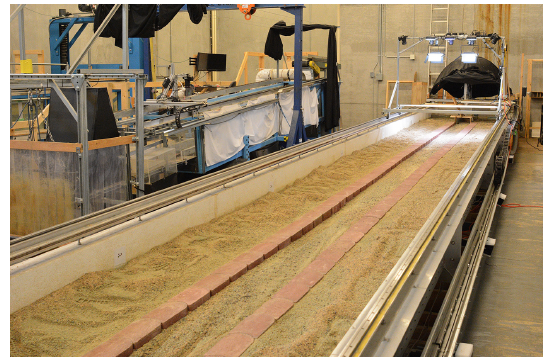
Figure 1. Adjustable-Boundary Experimental System (A-BES) at the University of British Columbia, featuring camera rig (top right) and bank control system at a width of